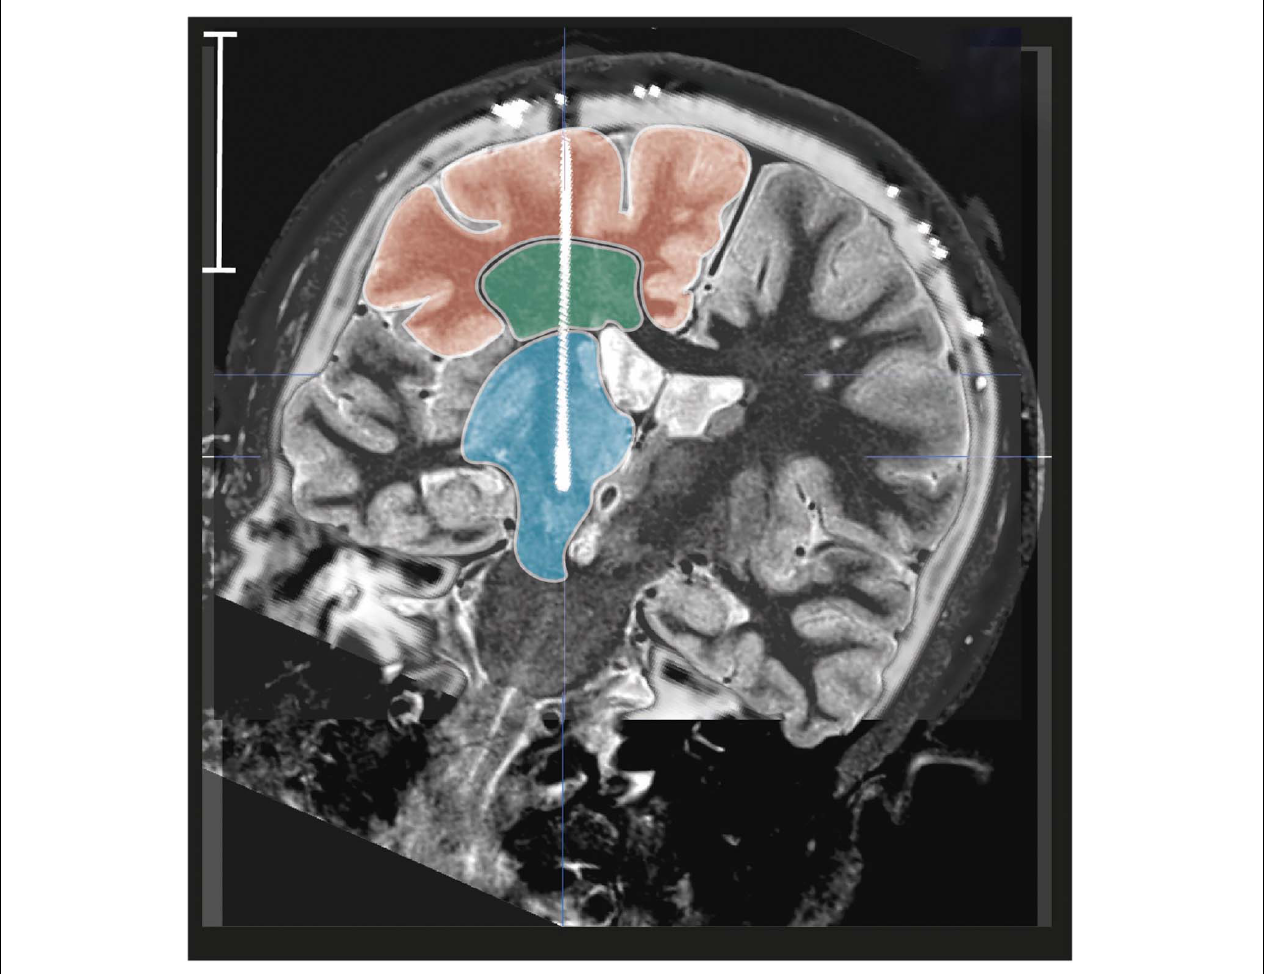
FIGURE 5 | Tissue layers. Example of overlay of postoperative CT scan and preoperative MRI (reconstructed pseudo coronal slice along the right electrode) showing the three tissue layers: the superficial gyration layer (red), the intermediate white-matter layer (green), and the deep brain layer (blue); white vertical bar = 50